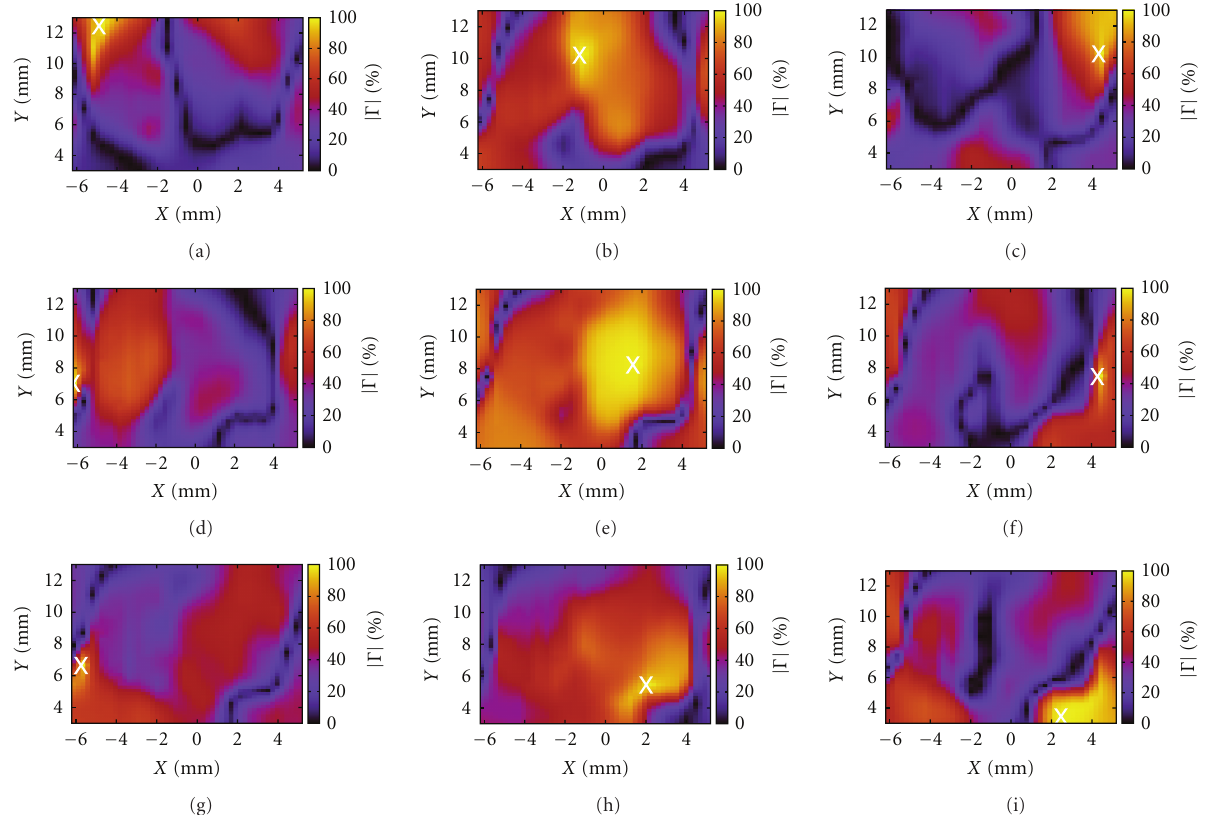
Figure 6: Some maps obtained by cross-correlation. The white cross indicates the point of greatest Γ